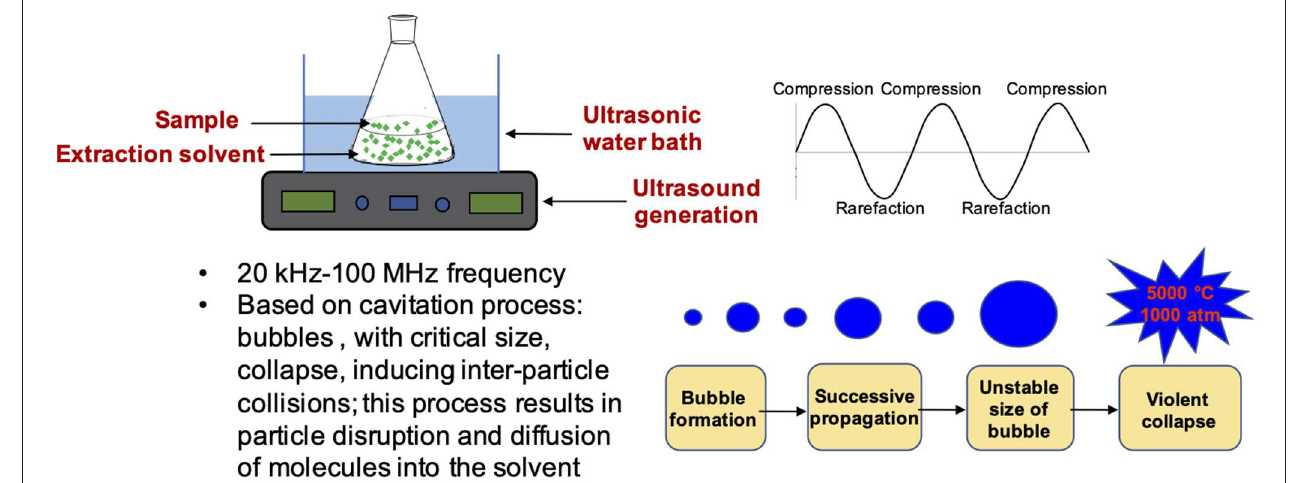
FIGURE 4 | Schematic representation of UAE equipment and characteristics.